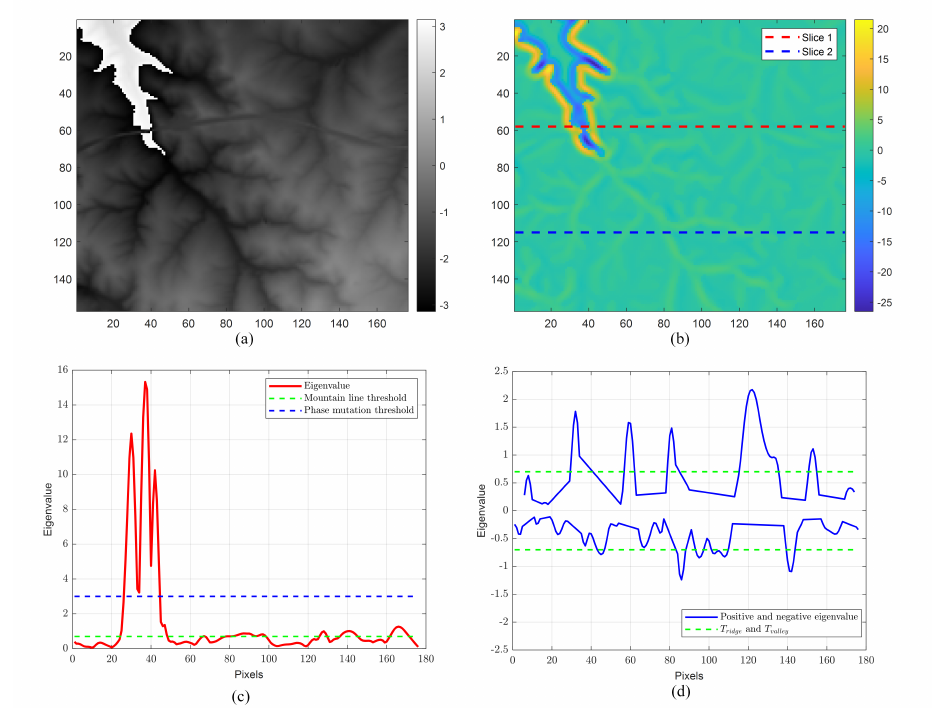
Figure 9. Analysis of the influence of phase winding. ( a ) The demonstration area of interference fringes with phase winding. ( b ) Interference fringe eigenvalue map. ( c ) Slice 1, with calculation of the absolute value. ( d ) Slice 2.